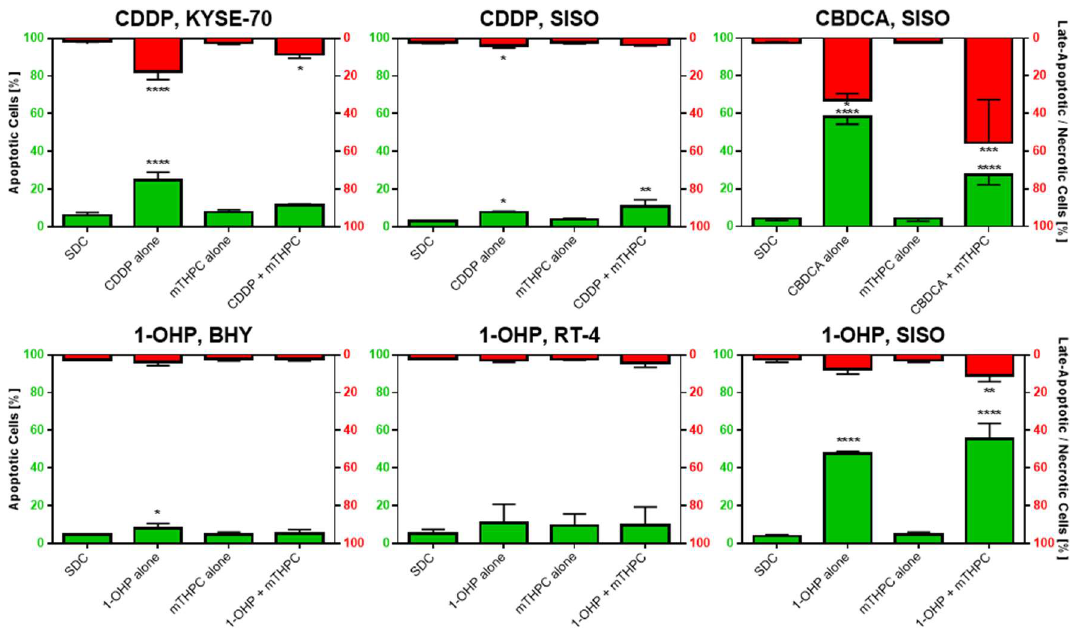
Figure 4. Apoptosis, detected by the Annexin V-FITC/PI method, after treatment with mTHPC-PDT, with a Pt(II) complex alone or after combination of both in various cell lines. Cells were illuminated 24 h after treatment with a light fluence of 1.8 J/cm 2 and stained with Annexin V-FITC and PI 48 h after illumination. The percentage of apoptotic cells (Annexin V-FITC-positive) is plotted on the left axis and the late-apoptotic cells (Annexin V-FITC- and PI-positive) are shown on the right axis in reversed orientation. Non-illuminated, solvent treated cells (solvent dark control, SDC) were used as the reference sample in statistical analysis. Data presented as means ± SD from at least three independent experiments. (* p < 0.05; ** p < 0.01; *** p < 0.001; **** p < 0.0001).